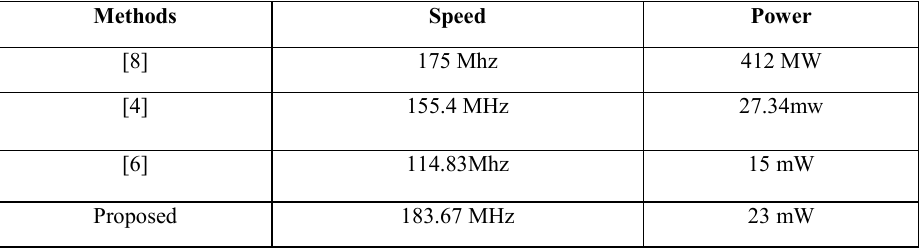
Table 2. Comparative analysis of proposed implementation with previous research